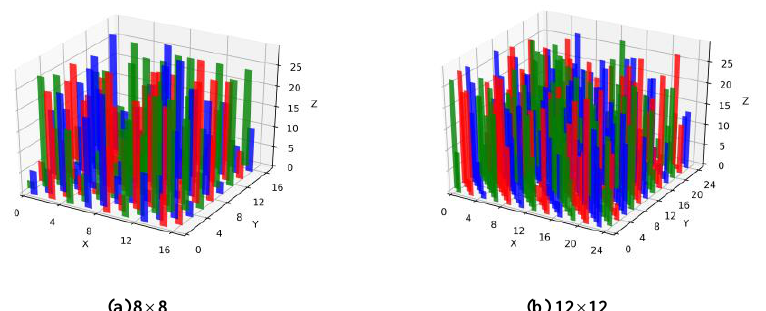
Figure 15. The accident distribution of the number of accidents on each road: ( a ) 8 × 8 intersections; ( b ) 12 × 12